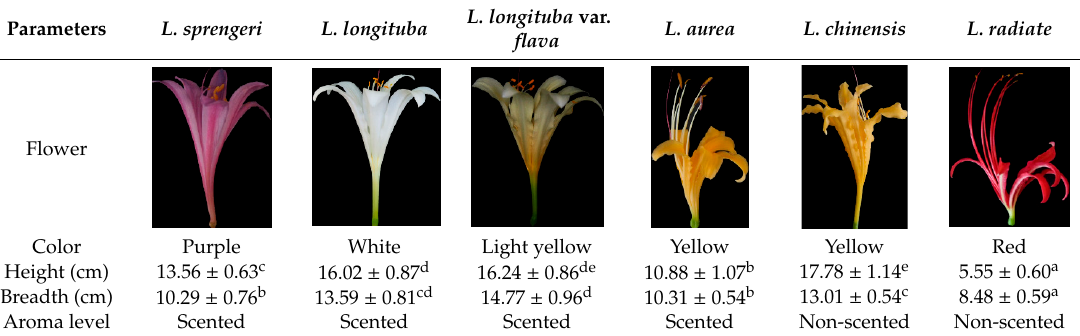
Table 2. Flower characteristics of six typical Lycoris taxa from a natural population. Parameters